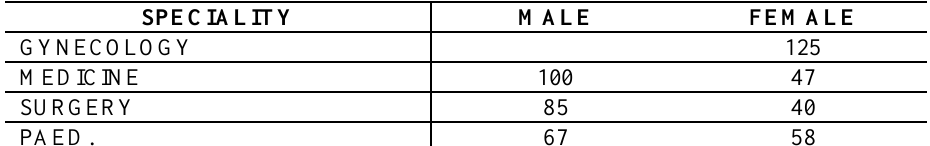
Table III : Total numbers of drugs prescribed in the hospitals